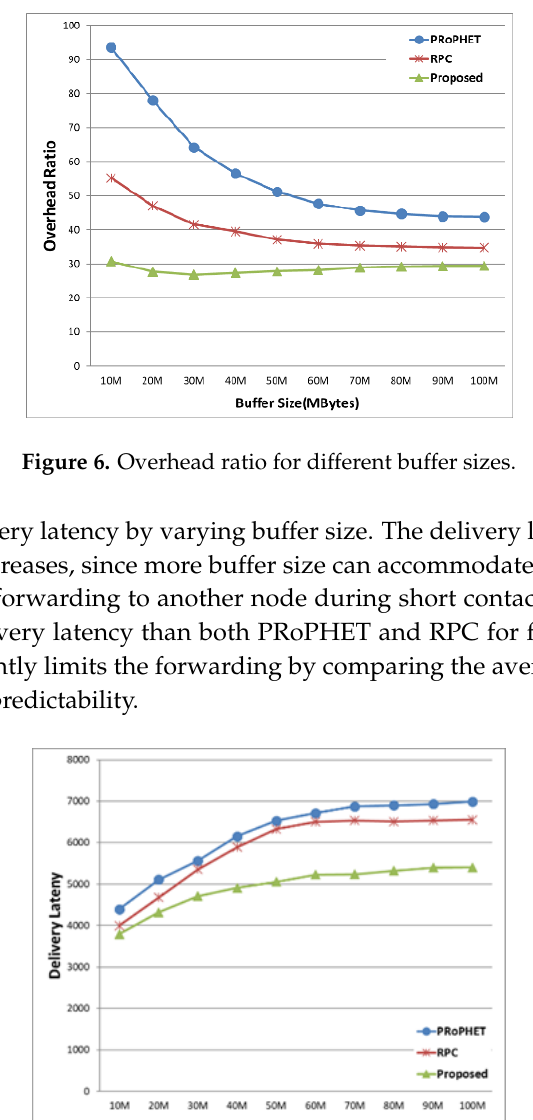
Figure 7. Dlivery latency for different buffer sizes.